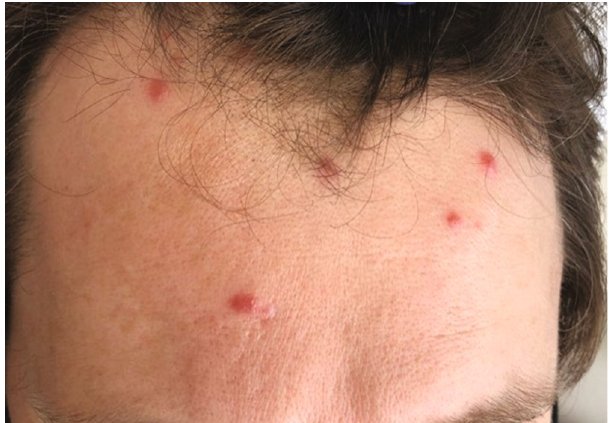
Figure 1: Clinical photograph showing multiple nodules on the patient ’ s